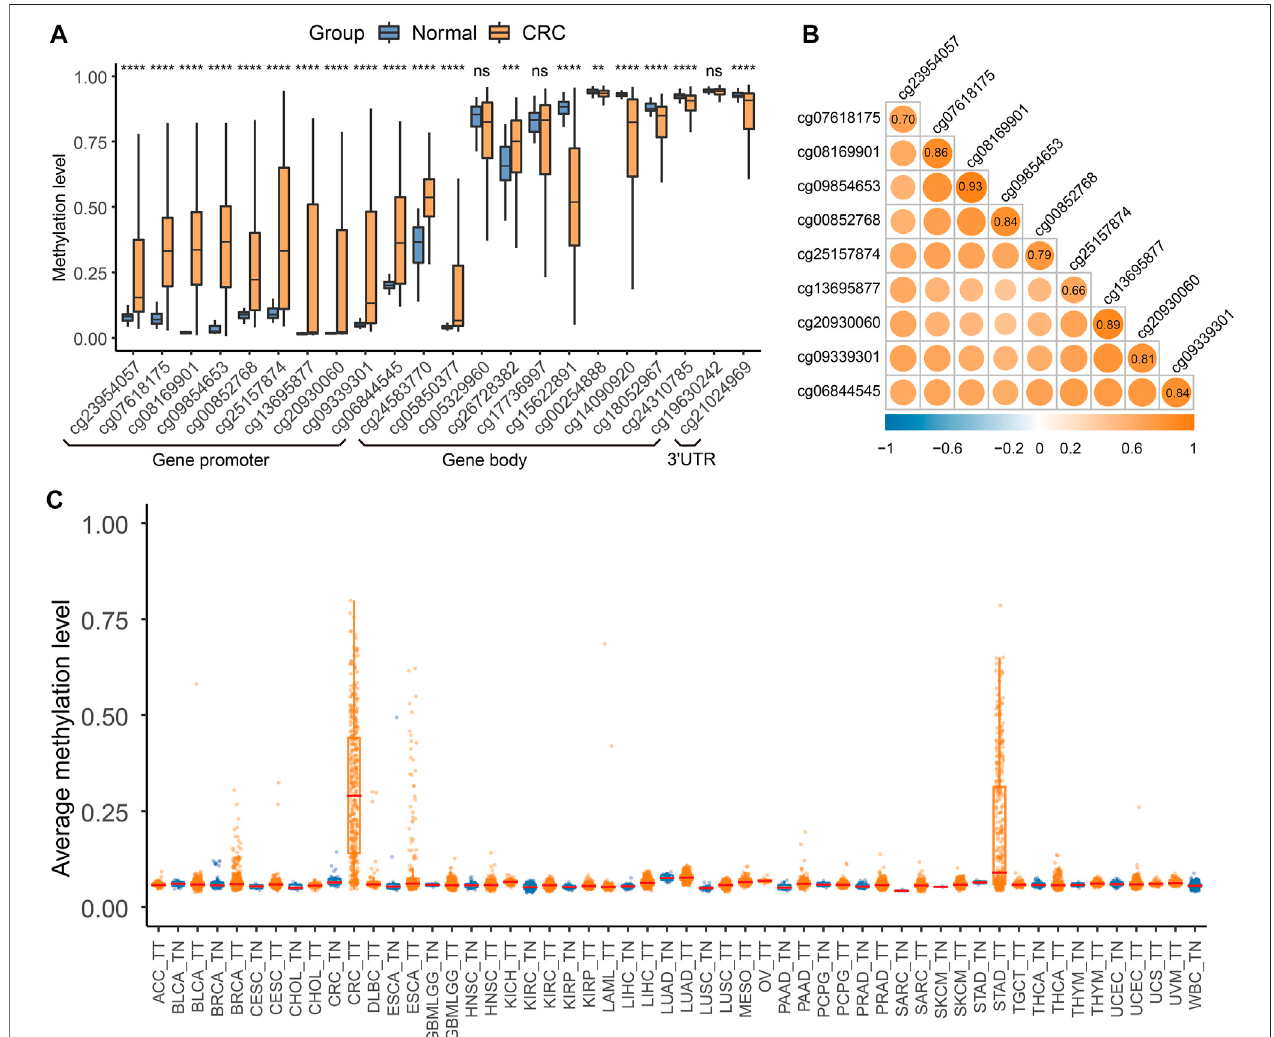
FIGURE 2 | QKI methylation analysis in the discovery dataset. (A) Differential methylation analysis for 22 CpG sites of the QKI gene between colorectal cancer tissues and normal tissues in the TCGA CRC dataset. Gene promoter was de fi ned as the region containing TSS200, TSS1500, 5 ′ UTR, and the fi rst exon. Symbols indicatingstatisticalsigni fi cance:NS, p > 0.05;*, p ≤ 0.05;**, p ≤ 0.01;***, p ≤ 0.001;****, p ≤ 0.0001. (B) Co-methylationanalysisof10CpGsitesinthepromoterregion of QKI . (C) Boxplot of the average methylation level of the QKI promoter in multiple